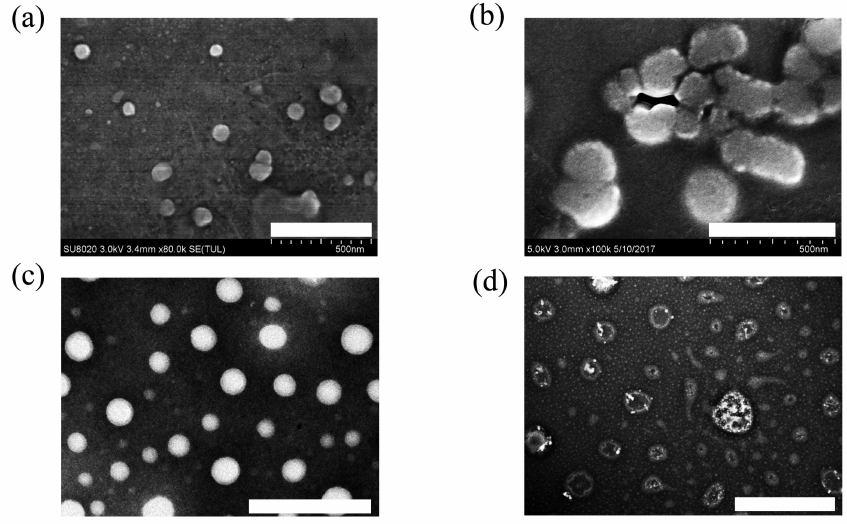
Figure 2. TEM images of G2 ( a ) (scale bar 500 nm), G2-C18 ( b ) (scale bar 500 nm), CSL-G2 NPs ( c ) (scale bar 200 nm), and CSL-G2-C18 NPs ( d ) (scale bar 500